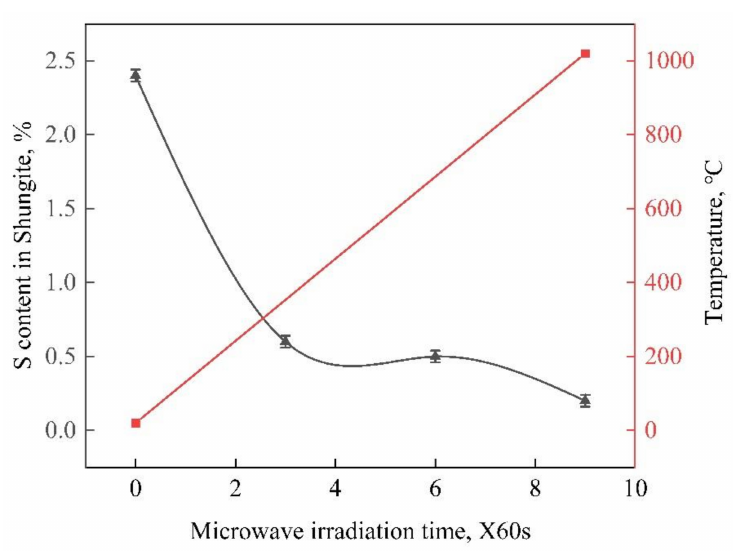
Figure 11. Change in the sulfur content of shungite with microwave irradiation